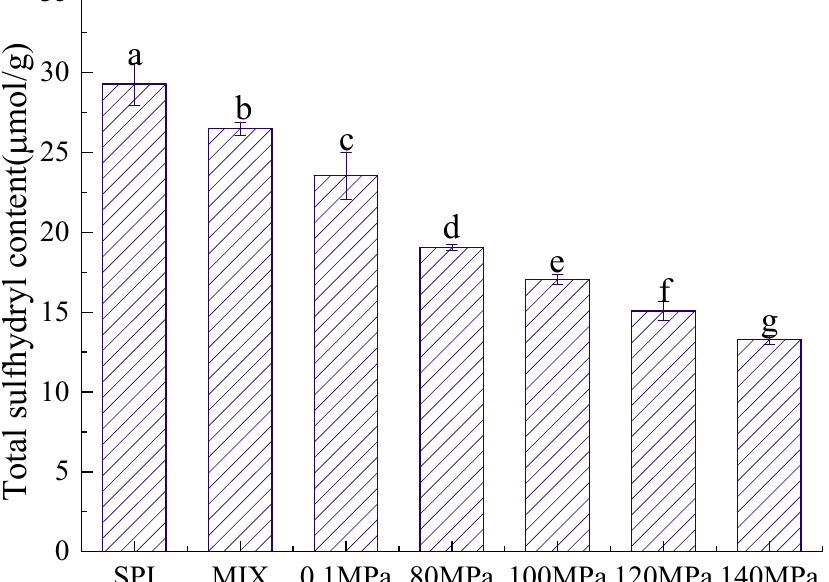
Figure 6. Total sulfhydryl content of the samples. SPI is the native soy protein isolate; MIX represents the mixture of SPI and GOS; 0.1 MPa represents the traditional wet heating Maillard reaction group; 80 MPa, 100 MPa, 120 MPa, and 140 MPa are the HPH treatment groups. The letters (a–g) indicate decreasing orders of magnitude ( p < 0.05).